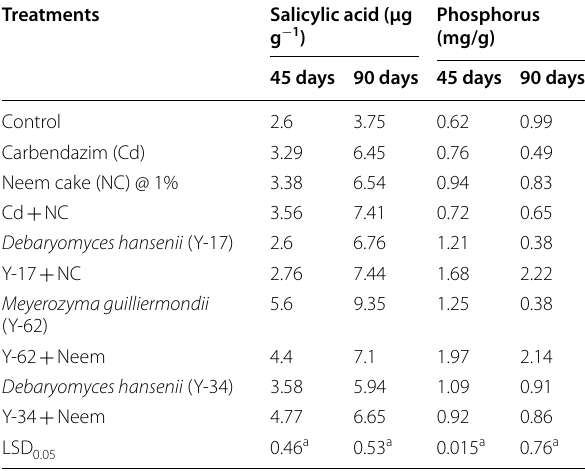
Table 7 Effect of endophytic yeast isolates on salicylic acid and phosphorus uptake by tomato plants in natural soil and soil amended with neem cake in field plot